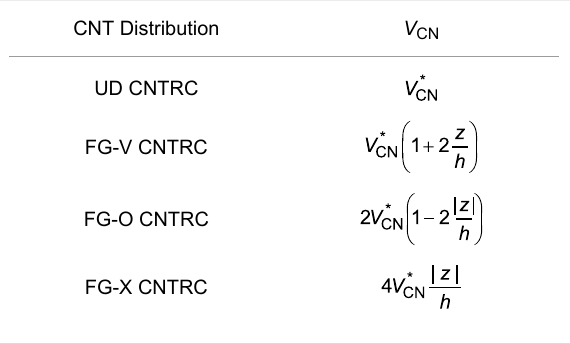
Table 1: Volume fraction of CNTs as a function of the thickness coor- dinate for various CNT distributions